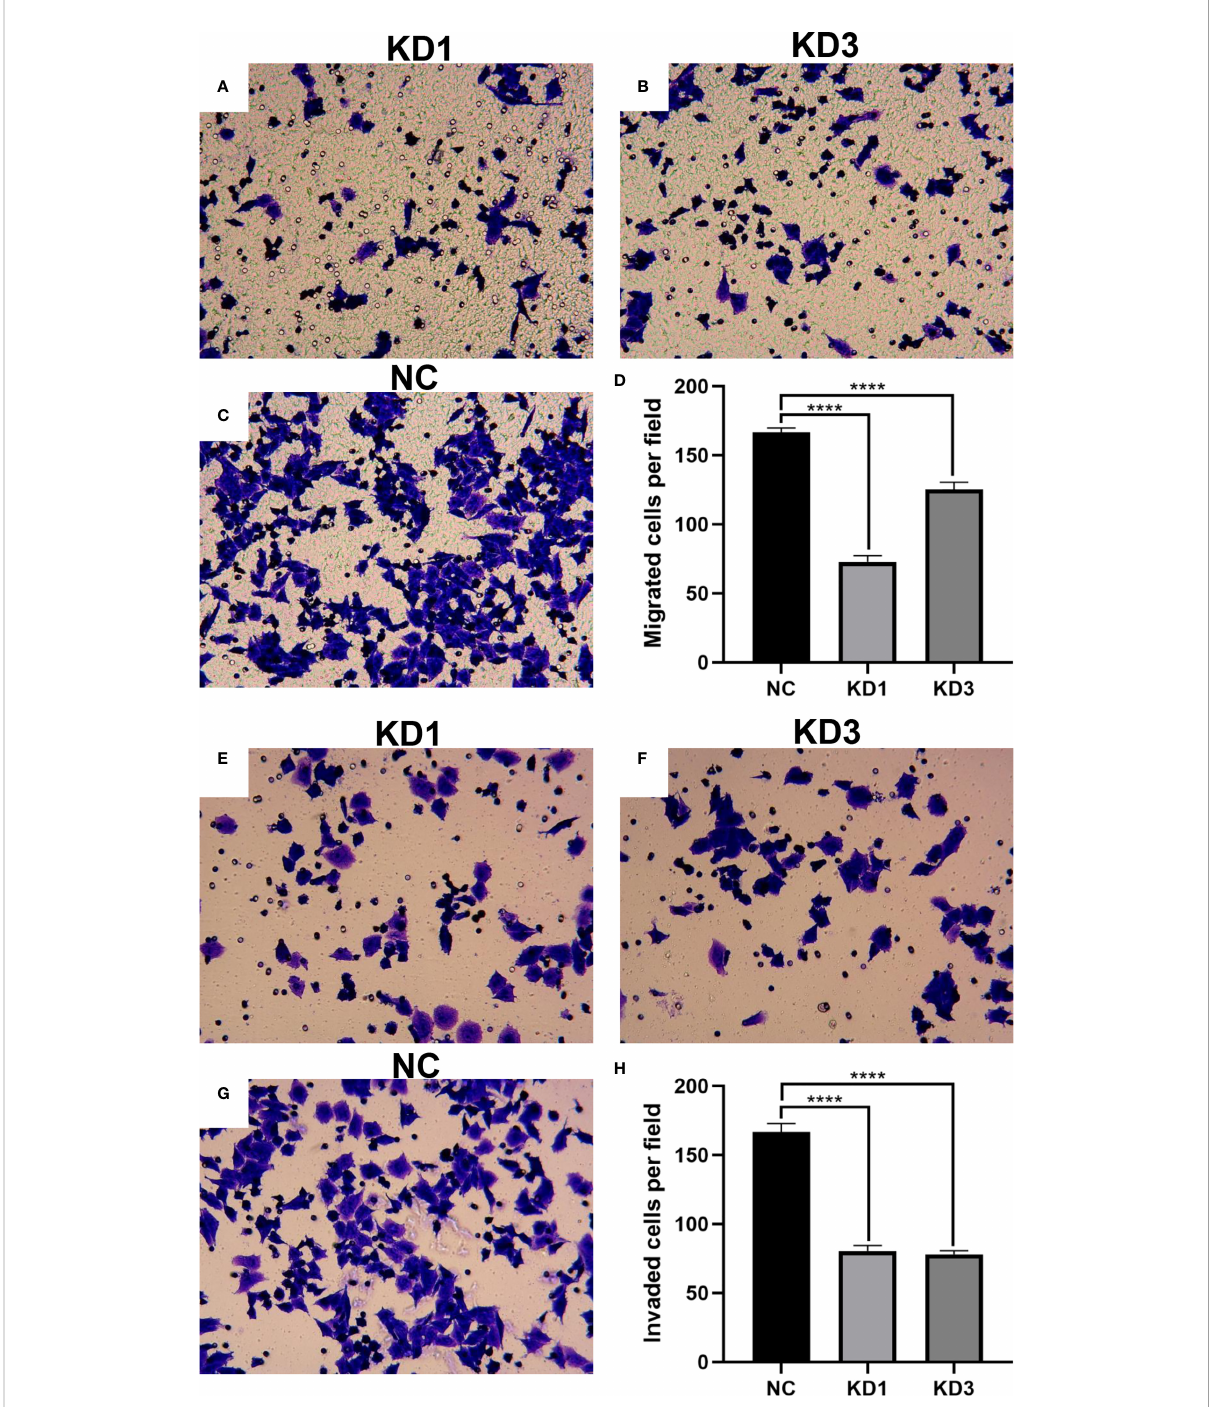
FIGURE 6 Effect of La RNAi on the migration and invasion of A2780 cells: migration chamber in the KD1 group (A) , KD3 group (B) , and NC group (C) , and the number of migration cells (D) . The effect of La RNAi on the invasion of A2780 cells: invasion chamber in the KD1 group (E) , KD3 group (F) , and NC group (G) , and number of metastatic cells in the invasion chamber (H) . All data were expressed as mean ± SD (**** P <